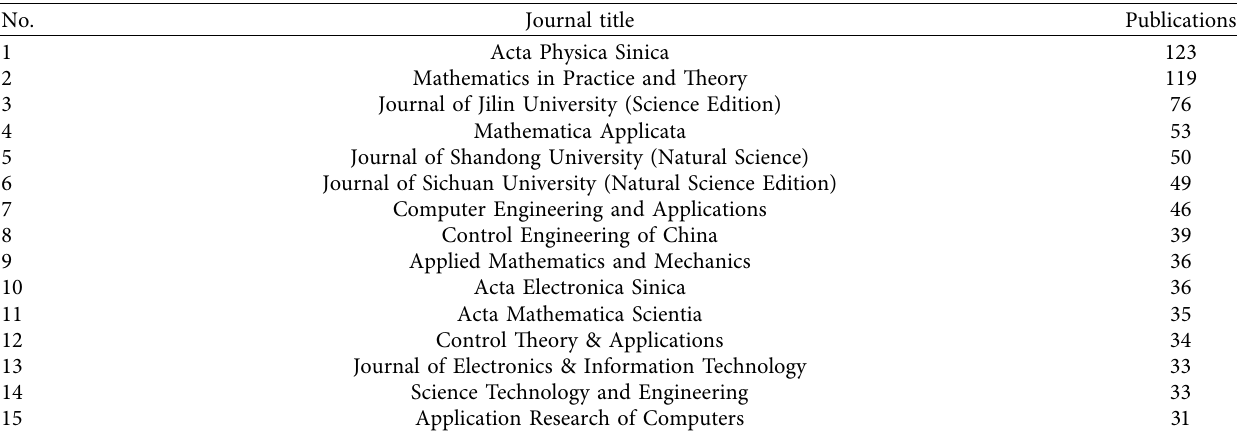
Figure 3: Author cooccurrence network. Note: due to the large number of authors in Figure 3 and limited space, this paper only translates the names of the following authors: 毛北行 � Mao Beixing; 蒋威 � Jiang Wei; 陶然 � Tao Ran; 蒲亦菲 � Pu Yifei; and 胡卫敏 � Hu Weimin. Table 1: Statistics of the top 15 journals